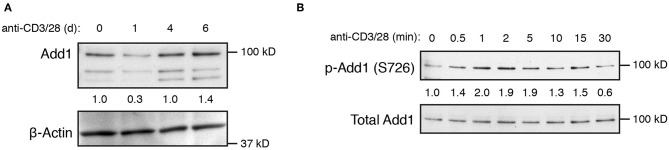
Add1 is rapidly phosphorylated upon TCR stimulation. (A) Expression of alpha-Adducin (Add1) was measured in CD4 T cells by western blot ex vivo and at d1, d4, and d6 after activation with anti-CD3 and anti-CD28. The two lower molecular weight bands are beta- and gamma-Adducin. (B) Phosphorylation of Add1 at Serine 726 was measured in naive CD4 T cells by western blot after anti-CD3 and anti-CD28 stimulation for the indicated times. Results are representative of two experiments.